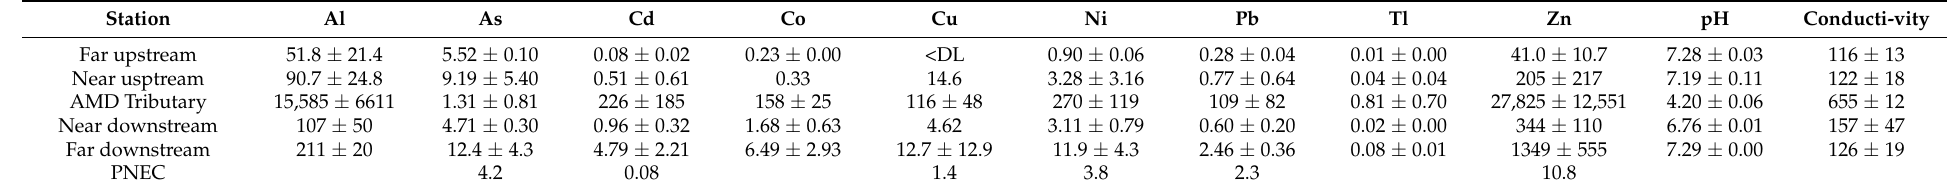
Table 1. Physicochemical characteristics (pH and conductivity in µ S.cm − 1 ) and metal concentrations ( µ g.L − 1 ) in the Beuveroux river, upstream and downstream to the acid mine drainage (AMD) tributary. Data are mean ± standard deviation ( n = 3). DL: detection limit. PNEC: Predicted No Effect Concentrations in water [27].